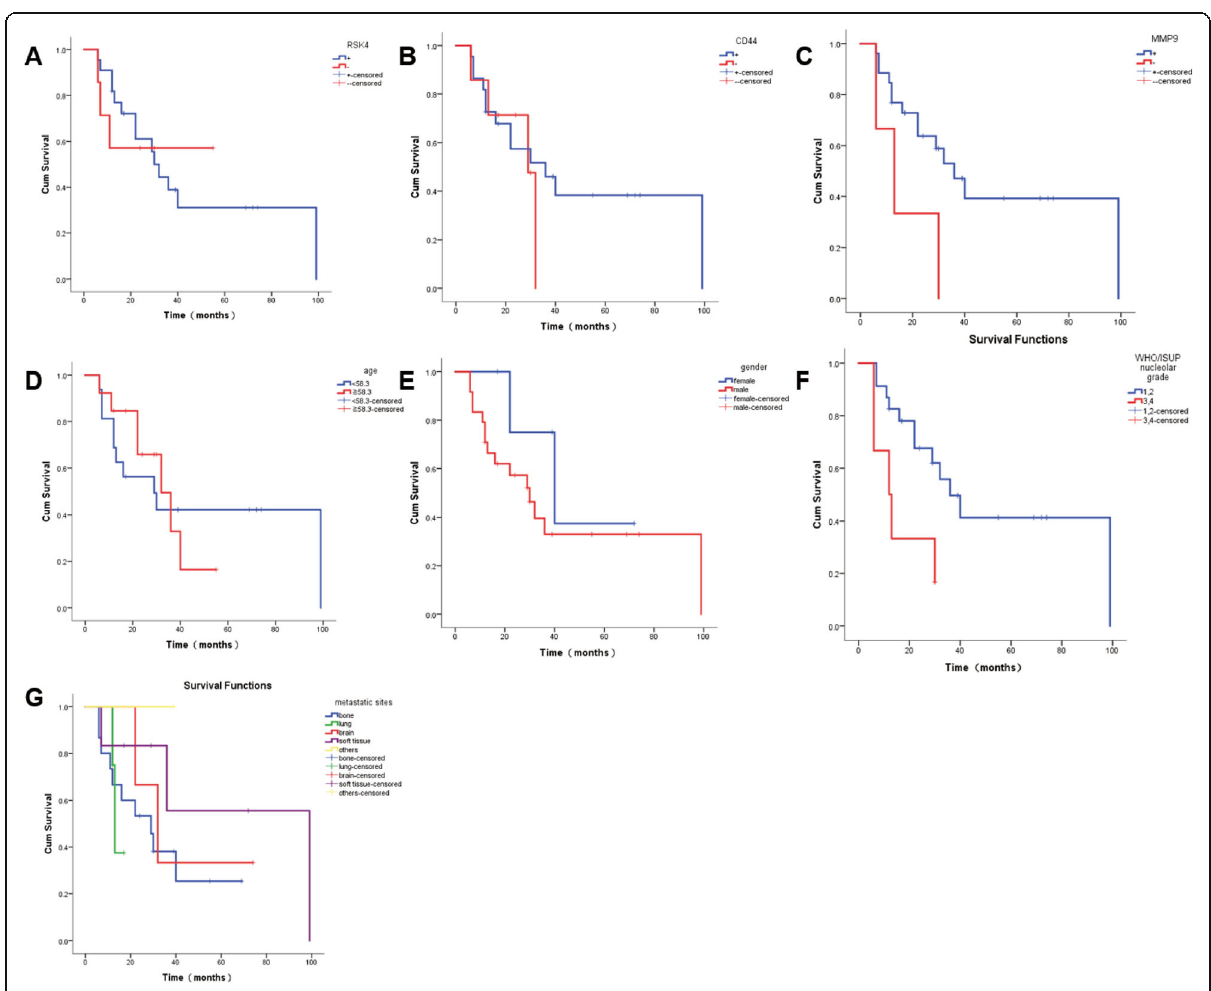
Fig. 2 Positive expression of MMP-9 predicts poor outcome of metastatic ccRCCs patients. The Kaplan-Meier survival curve showed the association between MMP-9 positive and negative expression in 29 metastatic ccRCCs patients ( P =0.038), and similar association was observed for WHO/ISUP nucleolar grade 1 – 2 and 3 – 4 ( P =0.018). However, RSK4, CD44, age, gender and metastatic sites were not statistically significant ( P >0.05). Figure a - f , blue line represents positive while red line represents negative. In figure g , blue, green, red, purple, and yellow represent bone, lung, brain, soft tissues and other metastatic sites, respectively. ( a ) RSK4; ( b ) CD44; ( c ) MMP-9; ( d ) age; ( e ) gender; ( f ) WHO/ISUP nucleolar grade; ( g ) metastatic